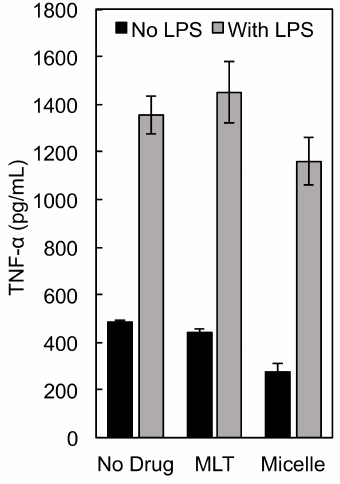
Figure 9. TNF- α expression levels in the presence of MLT and MLT micelles showing no increased production of TNF- α in the presence of MLT or PEG-P(MLT) micelles. Data shown as the mean ± S.D. ( n = 3).